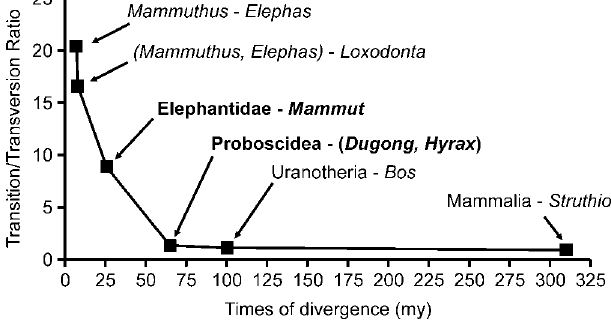
Figure 2. Ratio of the Number of Transitions to the Number of Transversions The six points correspond to the ratio between species of Elephantidae (first two points), between Elephantidae and Mammut, between Proboscidea and ( Dugong, Procavia ), between Uranotheria and Bos, and between Mammalia and Struthio . The corresponding divergence times for proboscideans are given in Table 2. Dugong and hyrax diverged from Proboscidea 65 mya [5,9]. We used 105 mya for the Uranotheria–ruminant split ([9] and citations therein). The mammalian– bird divergence was set to 313 mya (the mean value of the confidence interval of [62]; but see also [63,65]). The arrows indicate the points of interest. The uncertainty of the divergence times is not taken into account because the goal was to show the general trend.